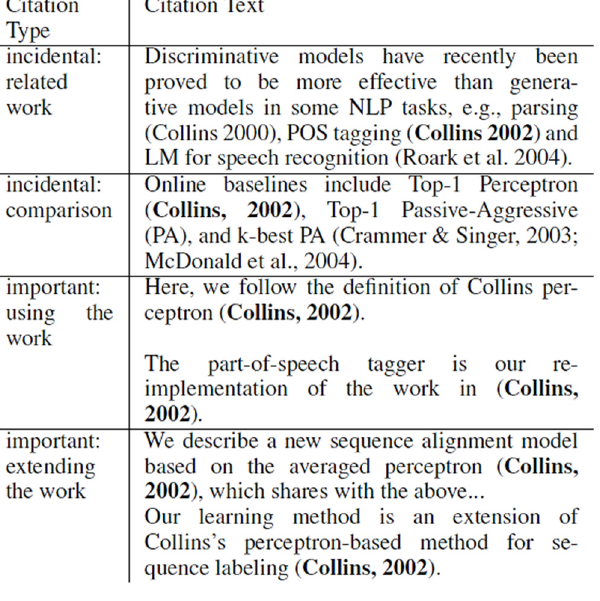
Figure 1. Semantic scholar process of identifying influential citations with examples listed in increasing order of importance (adapted from [26]).